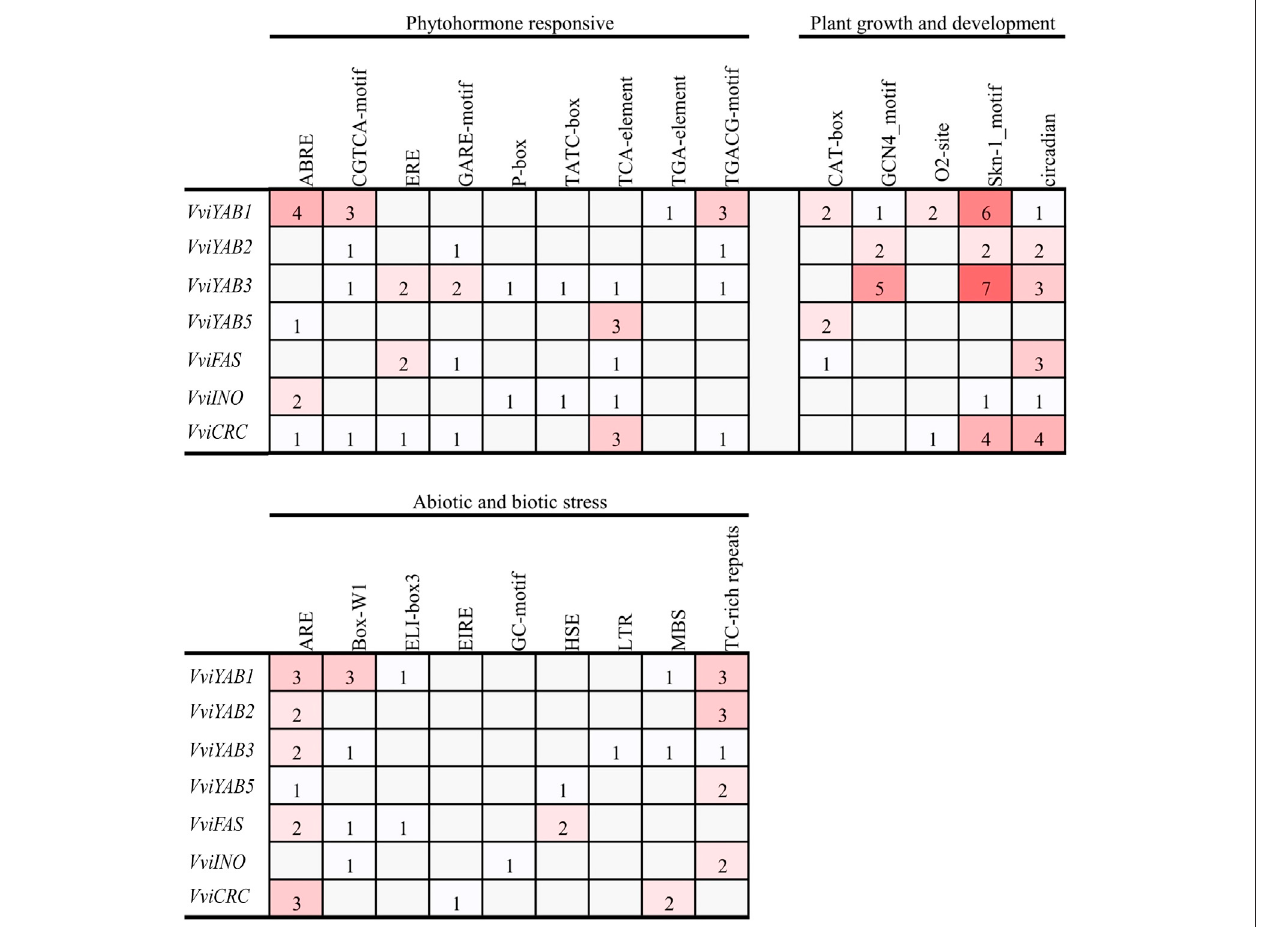
FIGURE3| The cis -regulatoryelementsanalysisofpromoterregionof VviYABs .Thenumberofeach cis -actingelementinthepromoterregion(1.5 kbupstreamof the translation start site) of VviYAB genes. Based on the functional annotation, the cis -acting elements were classi fi ed into three major classes: plant growth and development, phytohormone responsive, and abiotic and biotic stresses-related cis -acting elements.